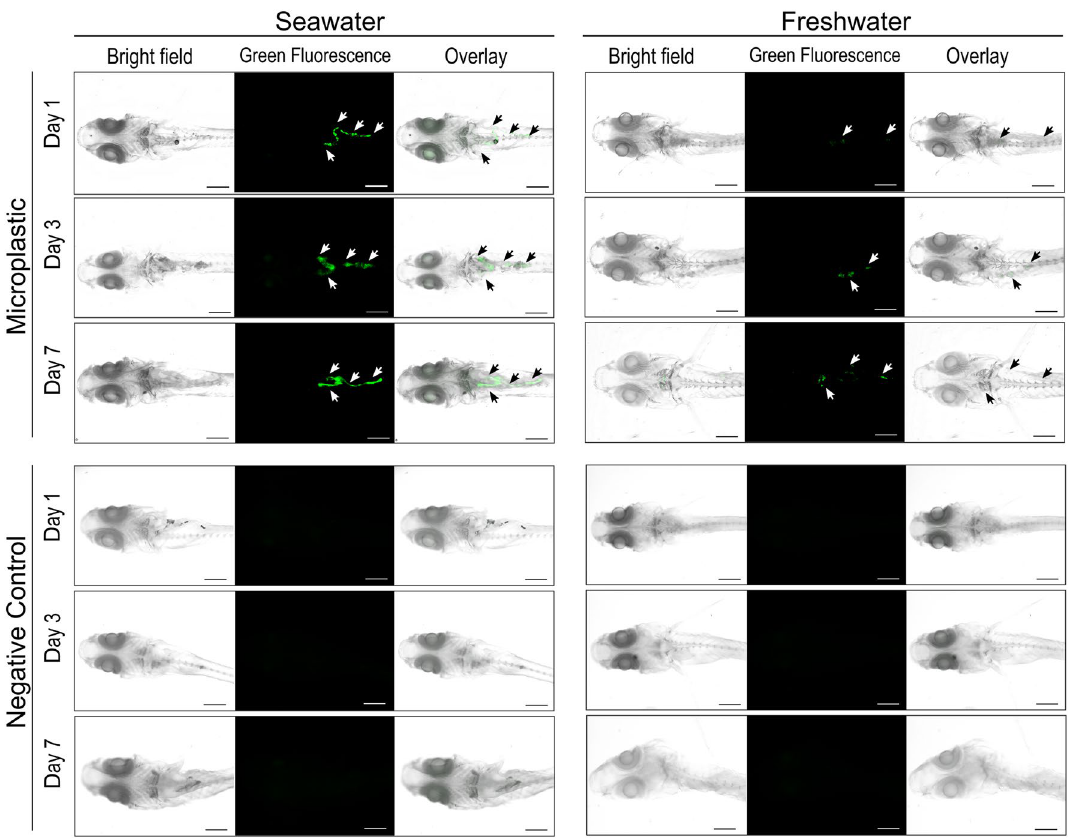
Figure 1. Microplastic distribution in the gastrointestinal tract of Oryzias javanicus ( Oj ) reared in seawater and freshwater. Images show Oj larvae exposed to fluorescently labeled microplastics at 0.25 mg/L for 1, 3, or 7 days. Images for negative controls were taken of Oj larvae cultured in water without microplastics for 1, 3, or 7 days. The scale bar indicates 0.5 mm. White and black arrowheads show the green fluorescent signal from microplastics in the gastrointestinal tracts of larvae. Caudal fins are not shown in this